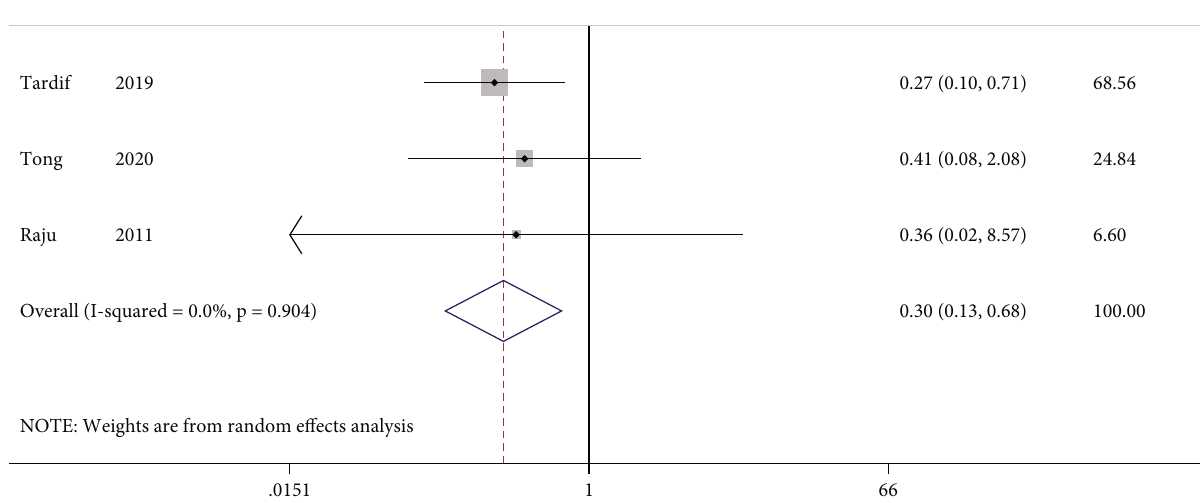
Figure 5: Forest plot displaying risk ratio and 95% con fi dence intervals for the impact of colchicine on stroke in patients with acute coronary syndrome. RR: risk ratio; CI: con fi dence interval.